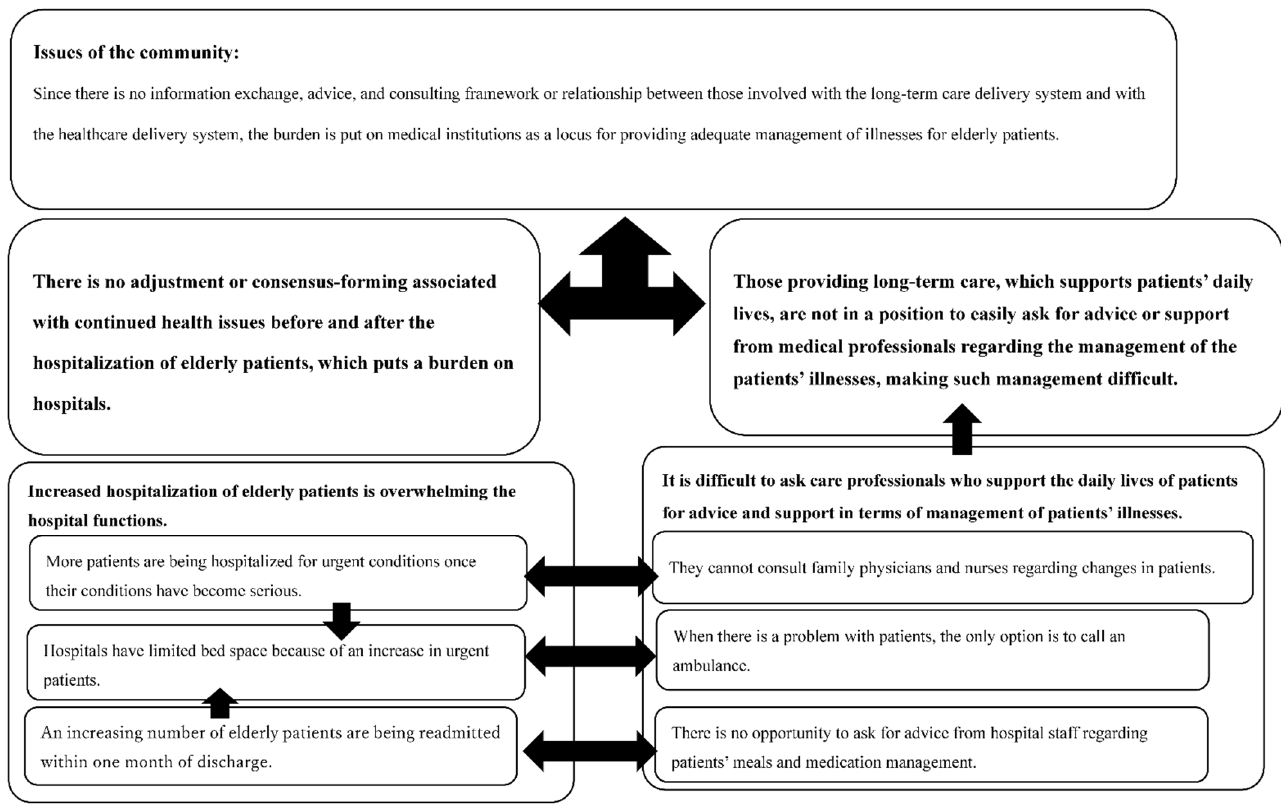
Figure 1. Visualization of information on community issues (rich picture).